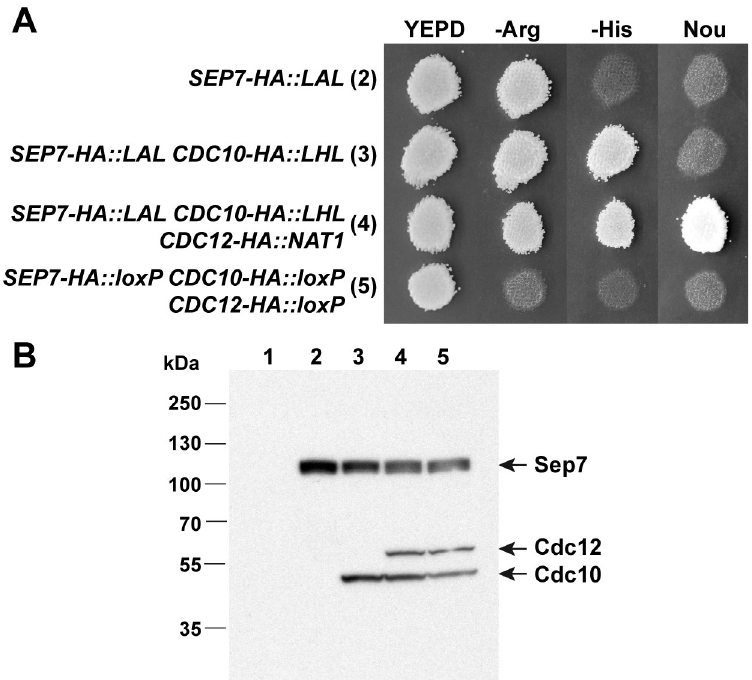
Fig 5. Multiple HA tagging. (A) Growth in selective media. Single colonies of strains SEP7-HA :: LAL/SEP7 (2), SEP7-HA :: LAL/SEP7 CDC10-HA :: LHL/CDC10 (3), SEP7-HA :: LAL/SEP7 CDC10-HA :: LHL/CDC10 CDC12-HA :: NAT1-Clox/CDC12 (4) and SEP7-HA :: loxP/SEP7 CDC10-HA :: loxP/CDC10 CDC12-HA :: lox/CDC12 (5) were grown on YPD plates and replica-printed to SC -Arg, SC -His or YPD+ nourseothricin media. (B) Western blot analysis of the same strains using anti-HA antibody. The BWP17 parental strain (1) was included as an untagged control. Protein extracts were separated on 4–12% Bis-Tris gels, blotted to PDVF membranes and incubated with anti-HA antibody.